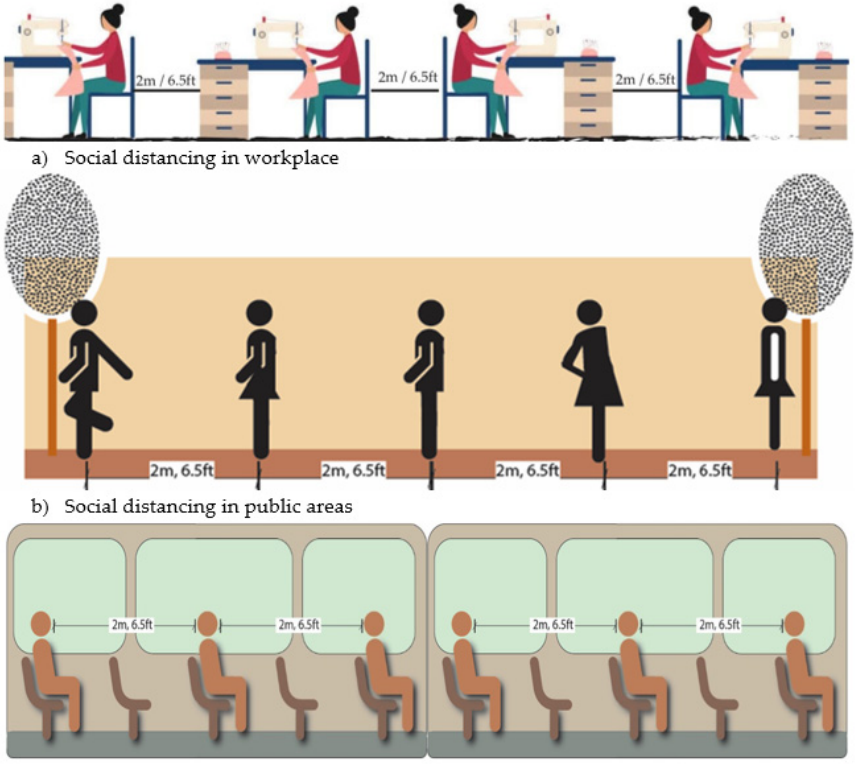
Figure 8. Illustrations of some practical measures to combat COVID-19; Social distancing is one of the pivotal strategies to prevent and mitigate the spread of COVID-19. Figure 8 depicts the different ways of social distancing in Industrial Park Oriented Urban Centers: ( a ) Social distancing in the textile manufacturing workplace ( b ) Social distancing in public places ( c ) Social distancing while using public transport. Source: authors,